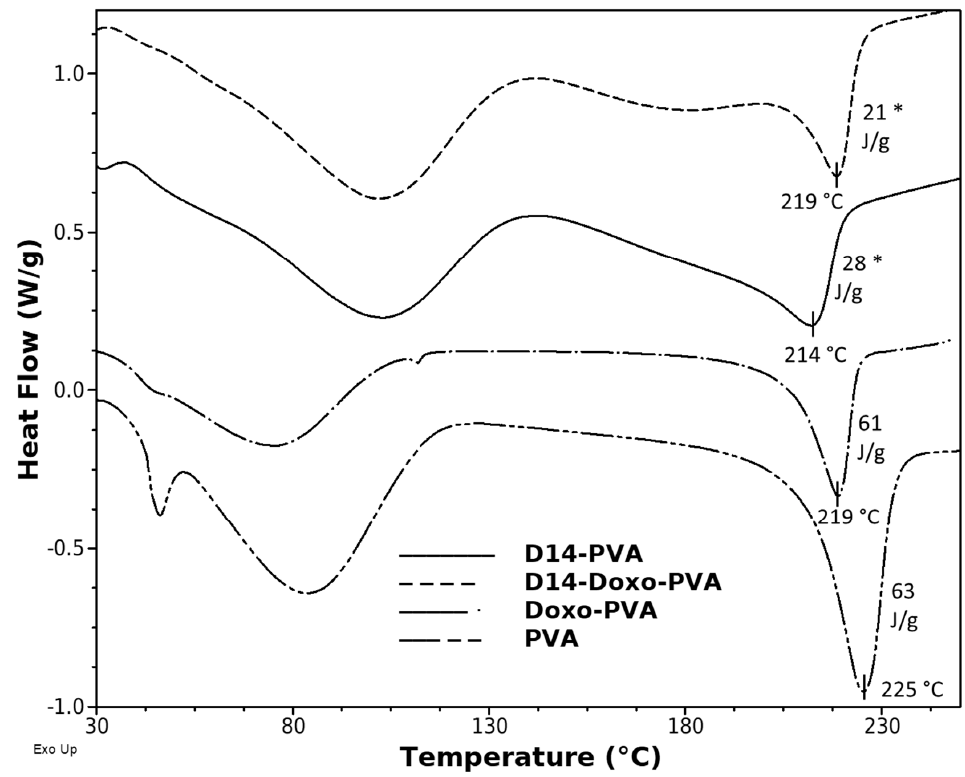
Figure 3. Differential scanning calorimetry thermograms of PVA spheres, D14-loaded PVA sphere, doxo-loaded PVA sphere and D14 and doxo-loaded PVA sphere. The y-axis represents watts/sample g (W/g). A statistically significant difference for D14 group is indicated by (*).